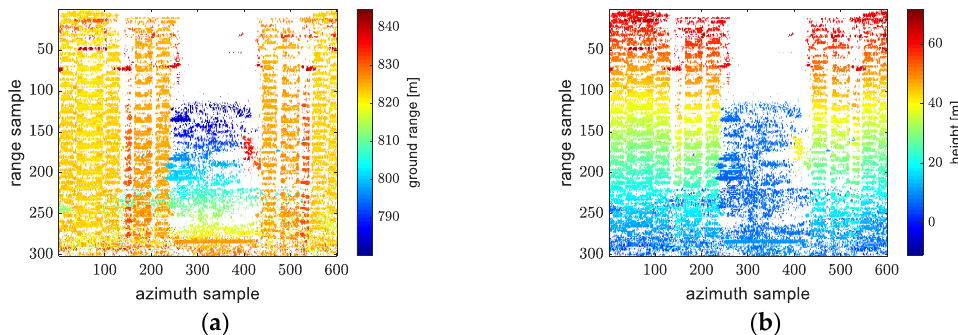
Figure 25. The target obtained by model 5 (the exact form of the spherical wavefront model) and shown in ( a ) 3-D point cloud and ( b ) 2-D SAR image.